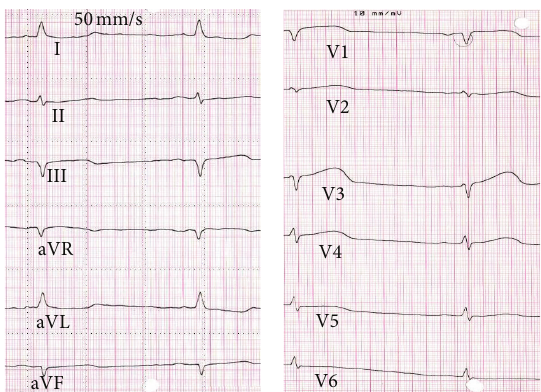
Figure 1: Coronary angiography after admission revealed long 90% diameter stenosis within the prestented right coronary artery (RCA), which was determined as the culprit lesion.